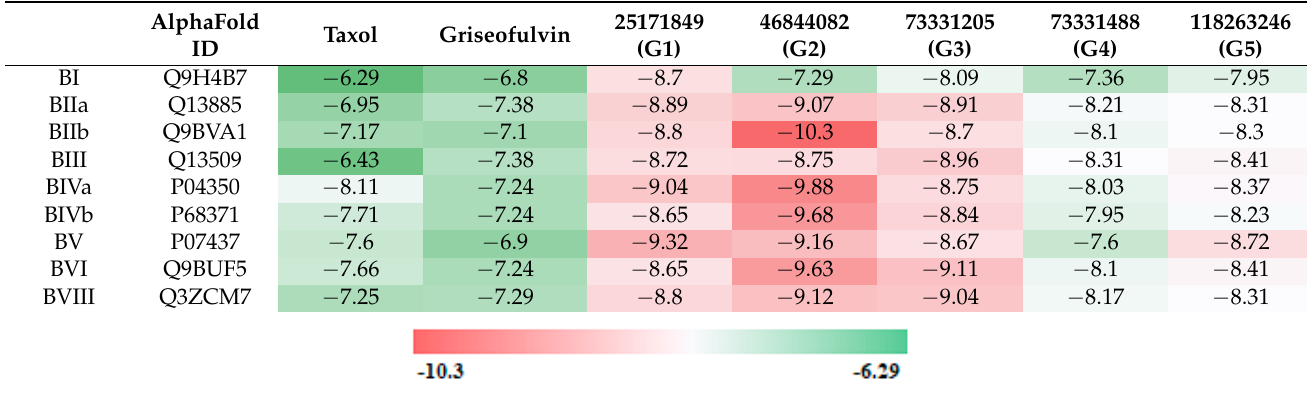
Table 2. Heat map of binding energies interactions between taxol, griseofulvin, and the five griseo- fulvin derivatives and nine distinct β -tubulin isotypes. Red colour indicates areas with the lowest binding energies and green indicates the highest binding energies.